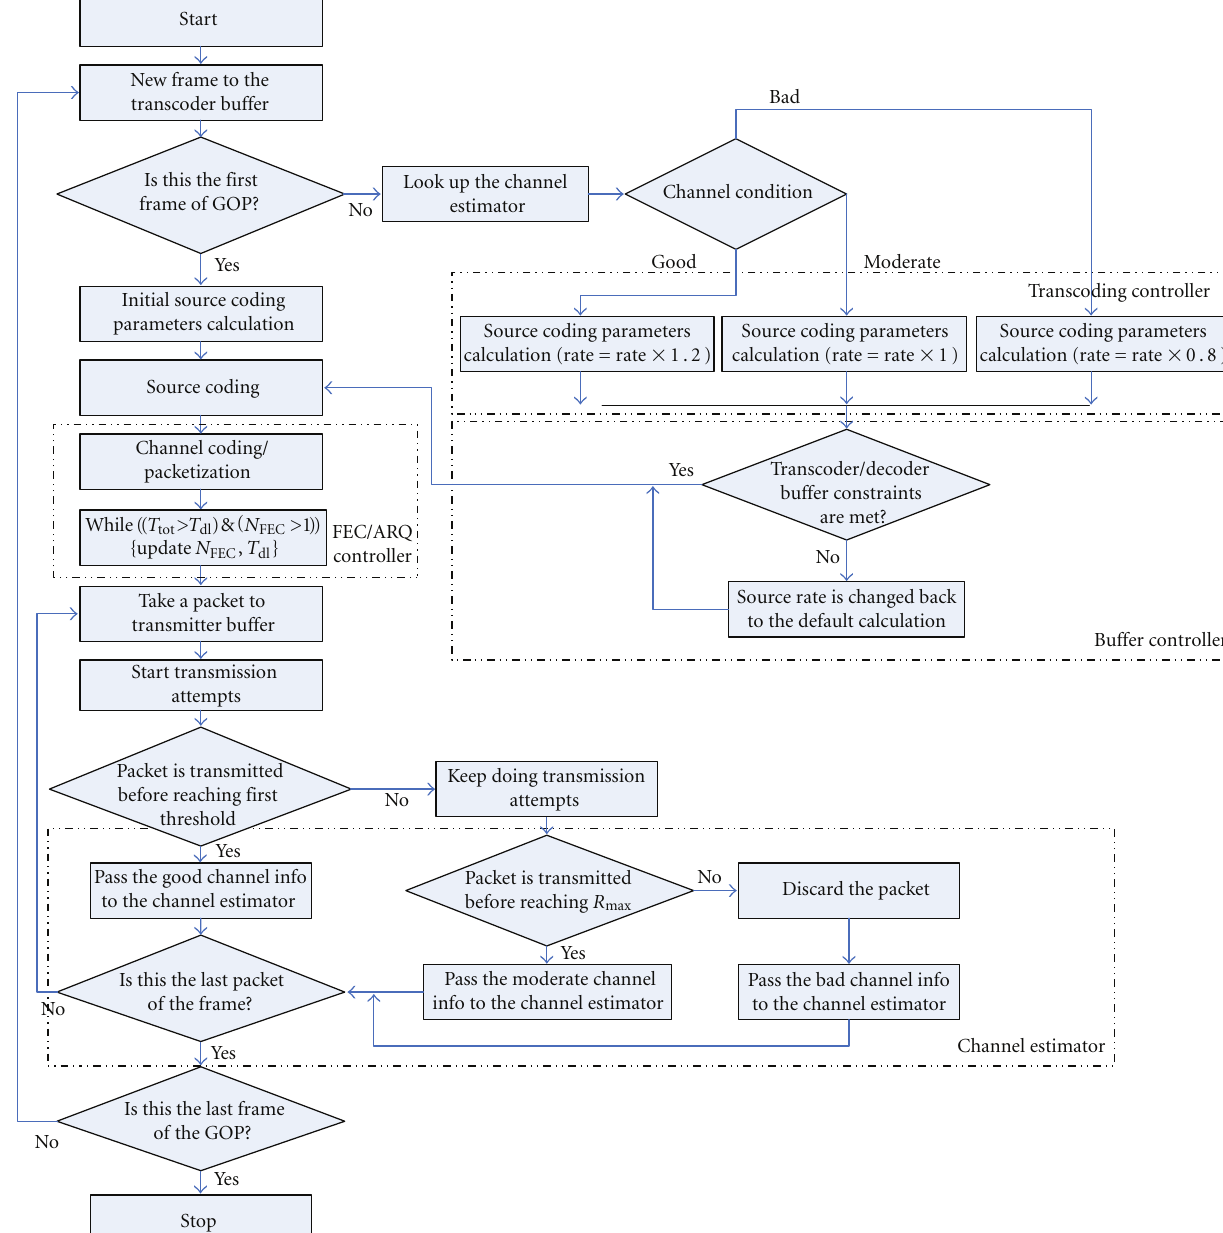
Figure 3: Flow of operations in the proposed framework (GOPs: group of